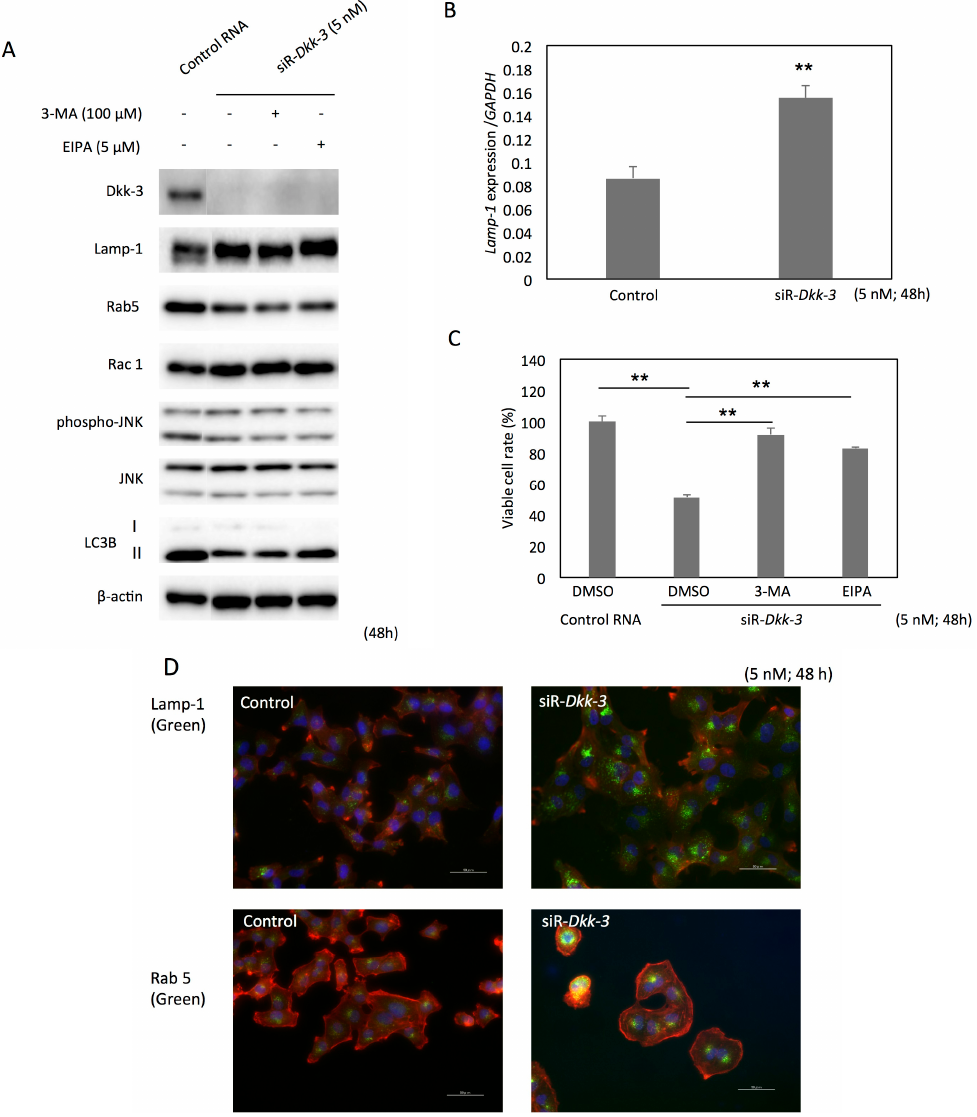
Figure 3. Cont. Figure 3.